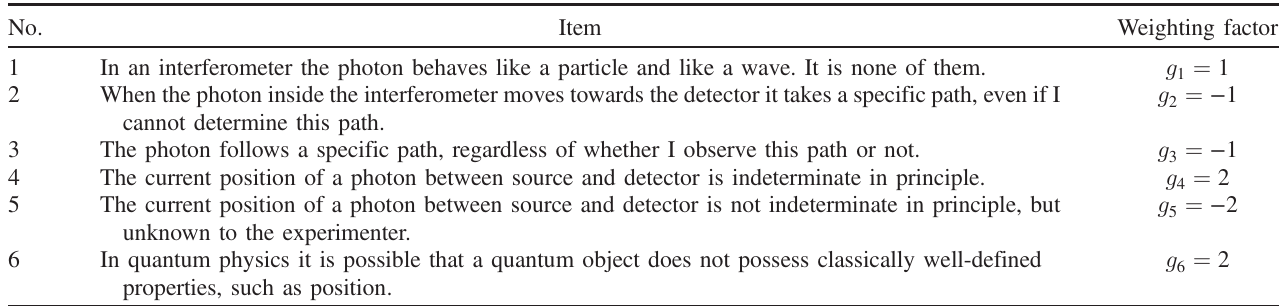
TABLE II. Items from the questionnaire on students ’ conceptions according to Müller [66] and translated into the setting single photon in the interferometer composing the scale quantum objects ’ properties and behavior.